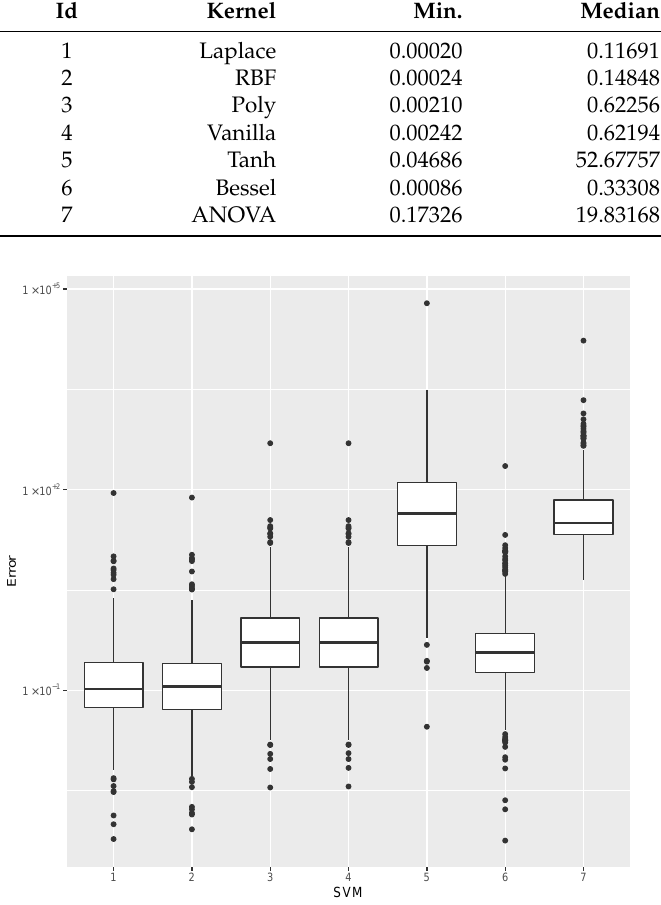
Figure 6. Error dispersion of the mass estimate using distinct SVM kernel options.